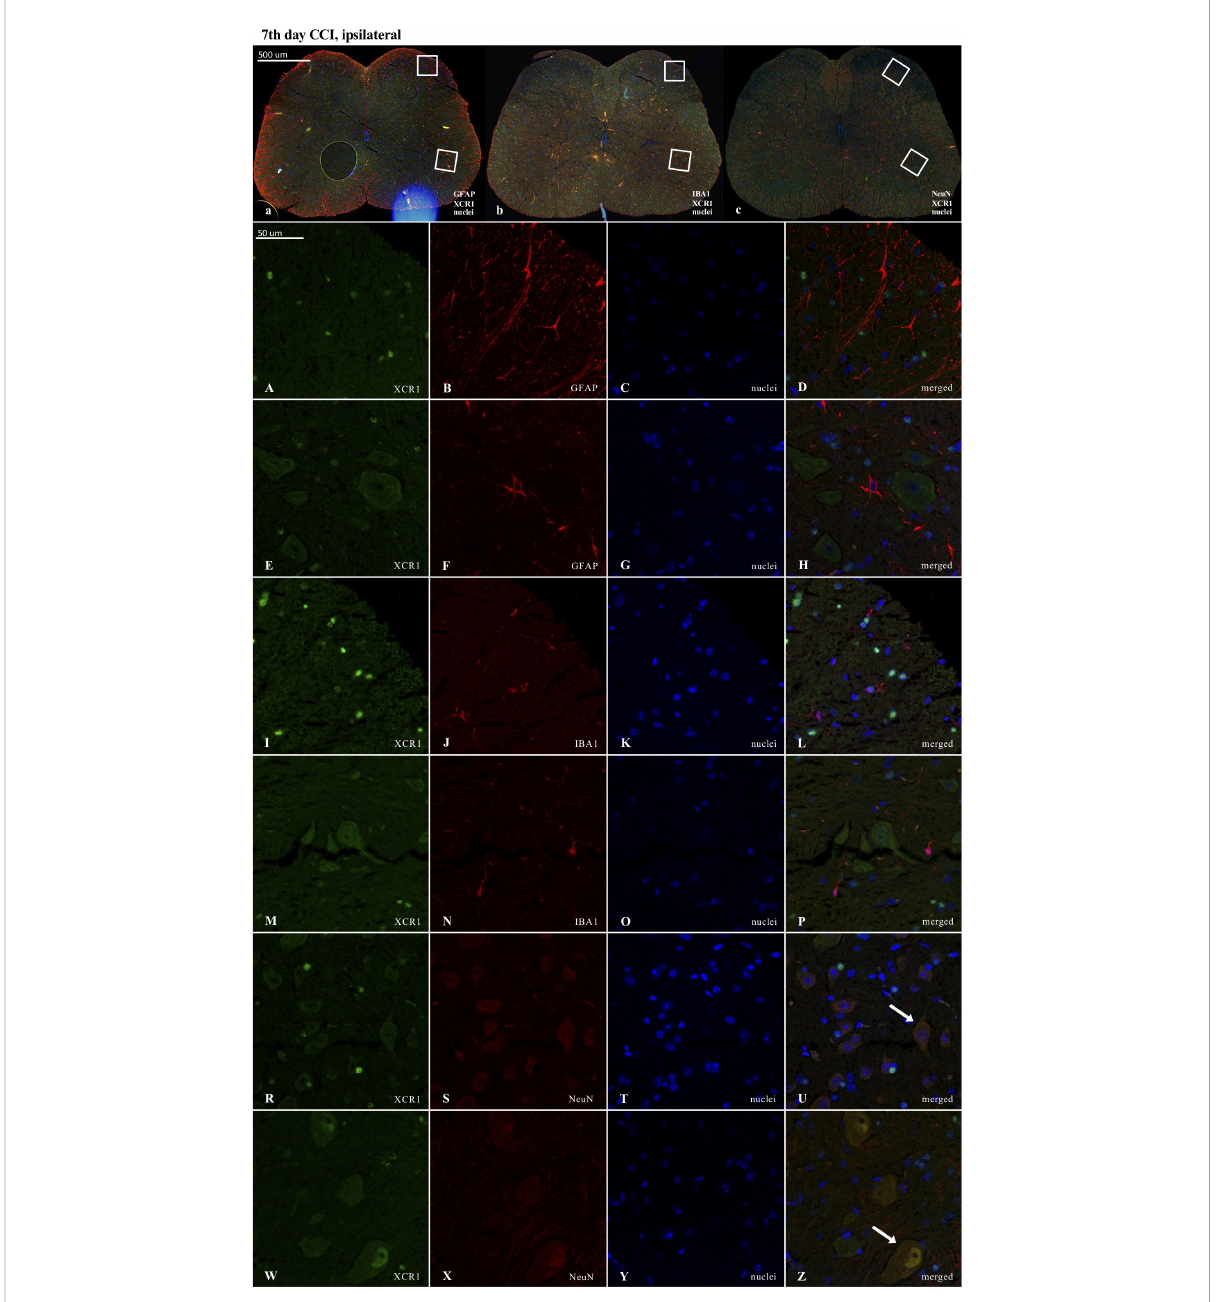
FIGURE 9 Immuno fl uorescence analysis of chemokine-C-motif receptor 1 (XCR1) localization in the lumbar (L4 to L6) spinal cord 7 days after chronic constriction injury (CCI) of the sciatic nerve in mice. Dorsal (A – D, I – L, R – U) and ventral (E – H, M – P, W – Z ) parts of lumbar spinal cord ( a,b,c ) were shown as an approximate fragments of selected images. Representative immuno fl uorescence images from colocalization analysis performed on spinal cord, paraf fi n-embedded 7 m M microtome slices: XCR1 (green: A, E, I, M, R, W ) with astroglia marker glial fi brillary acidic protein; (GFAP, red: B,F ); microglia marker ionized calcium-binding adaptor molecule 1; (IBA1, red: J, N ); and with neuronal marker neuronal nucleus; (NeuN, red: S, X ), Nuclei are in blue ( C, G, K, O, T, Y ). High magni fi cation, three-dimensional image rendering shows XCR1 localization inside NeuN-positive cells (yellow: U, Z ). Scale bars: 50 m m ( a, b, c ), 500 m m (A – Z)